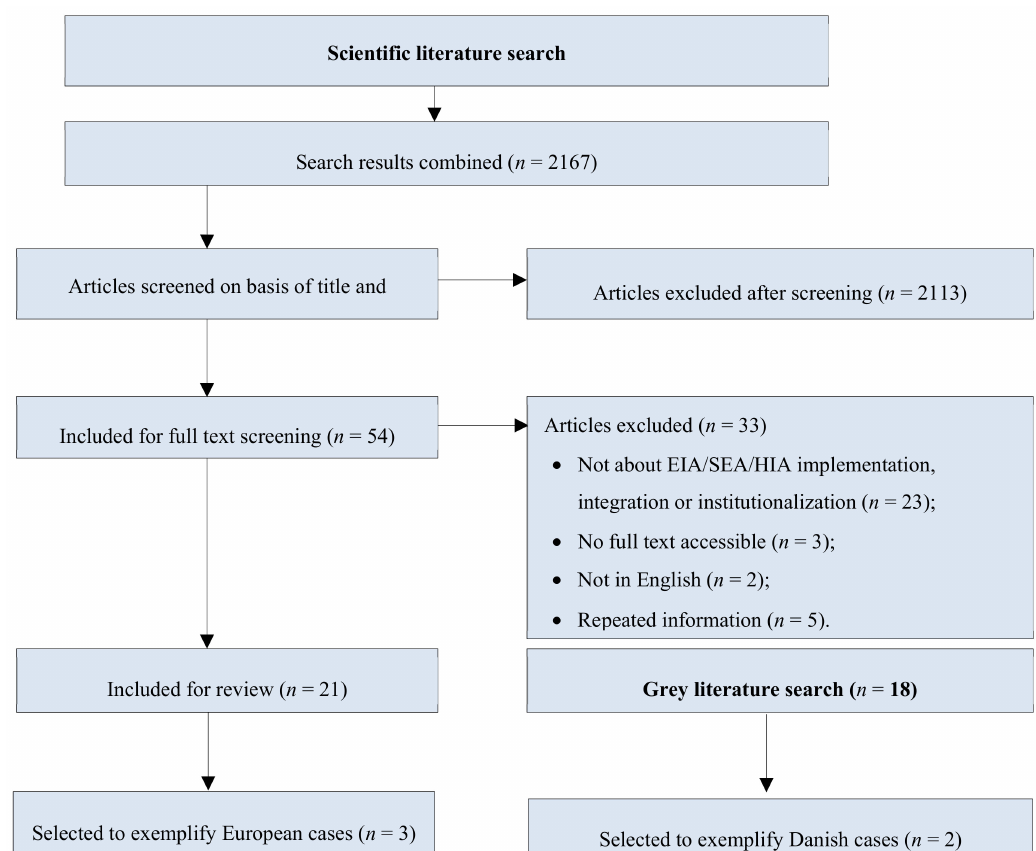
Figure A1. Literature screening process.